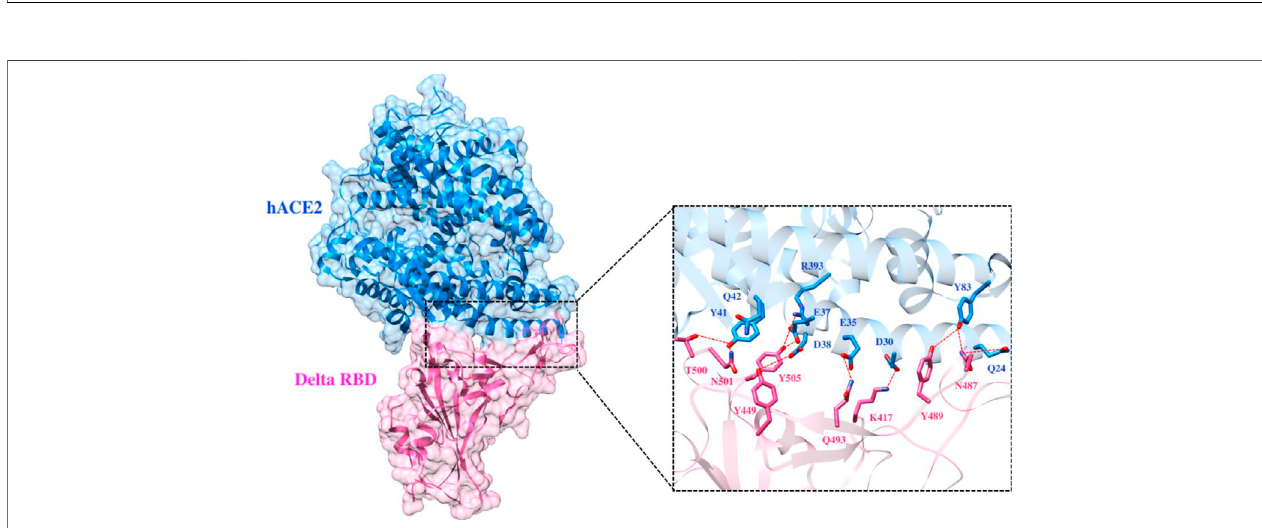
FIGURE6| InterfacialbindinginteractionsbetweenDelta RBD and ACE2 receptor. RBD and ACE2 residues are colored asmagenta and blue sticks,respectively, while red dotted lines represent the hydrogen bonds.